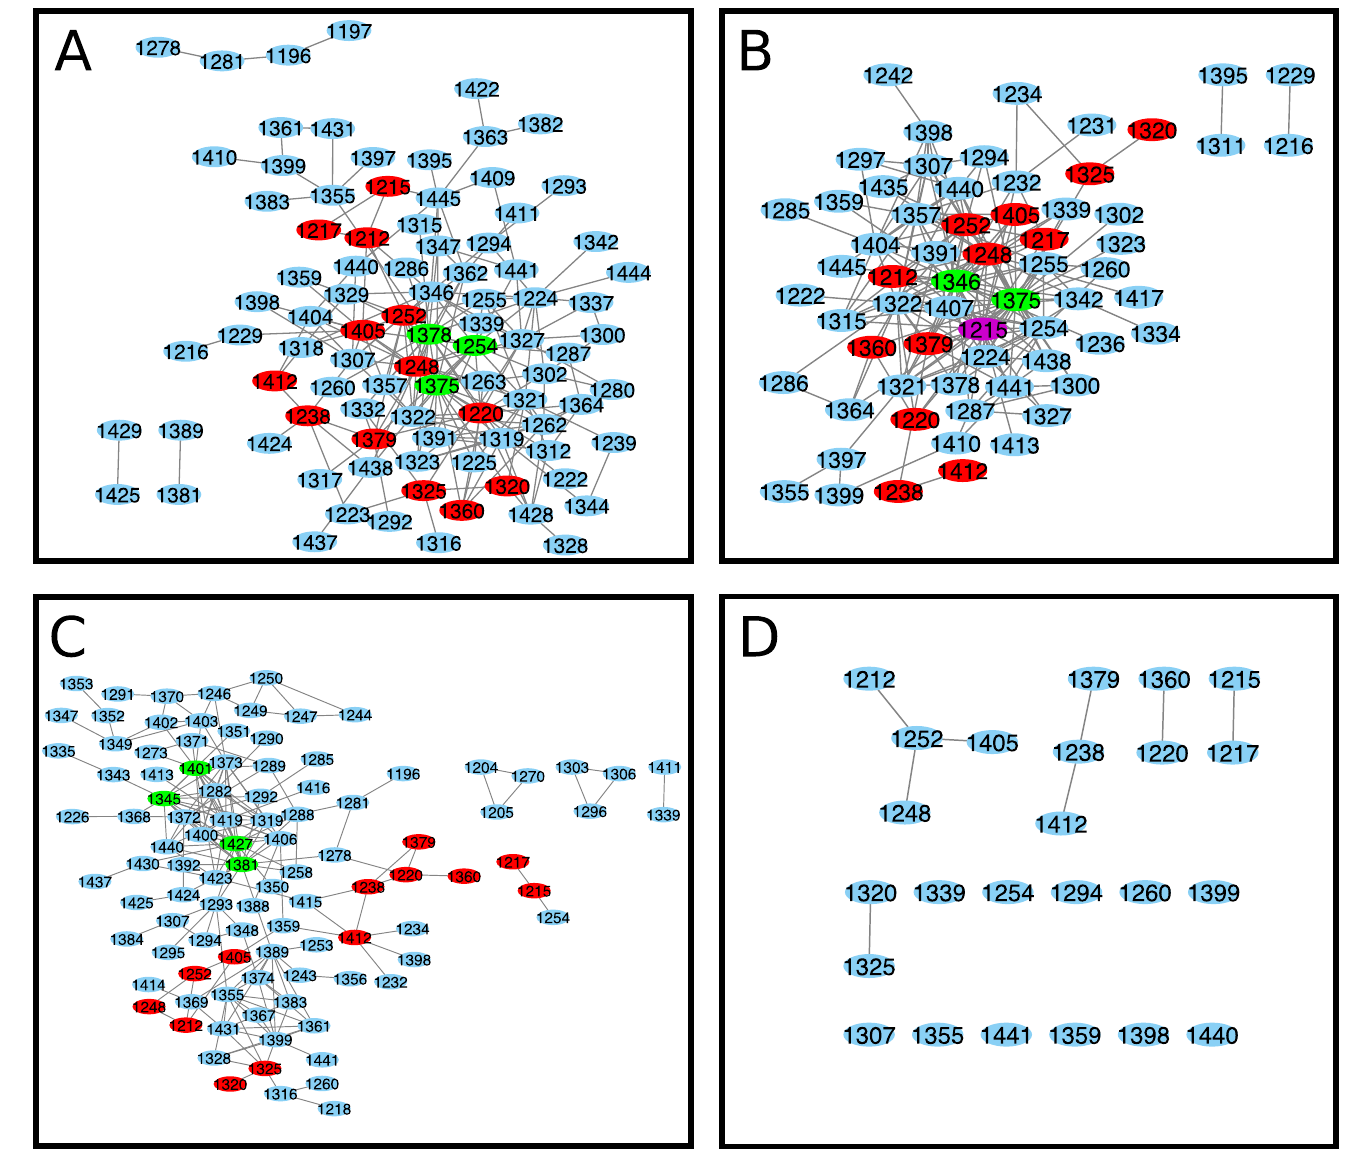
Fig 3. NBD2 Cytoscape interaction maps for matrices. (A) ELSC coupling matrix (B) OMES coupling matrix (C) McBASC coupling matrix (D) Composite of ELSC, OMES, and McBASC analyses. Composite map generated from the individual maps using the top 200 coupled positions common to all (ELSC, OMES, McBASC) using Cytoscape software [50]. Nodes that are central and overlap in all analysis are colored purple. Nodes that overlap in all analysis are colored red, and central nodes are colored